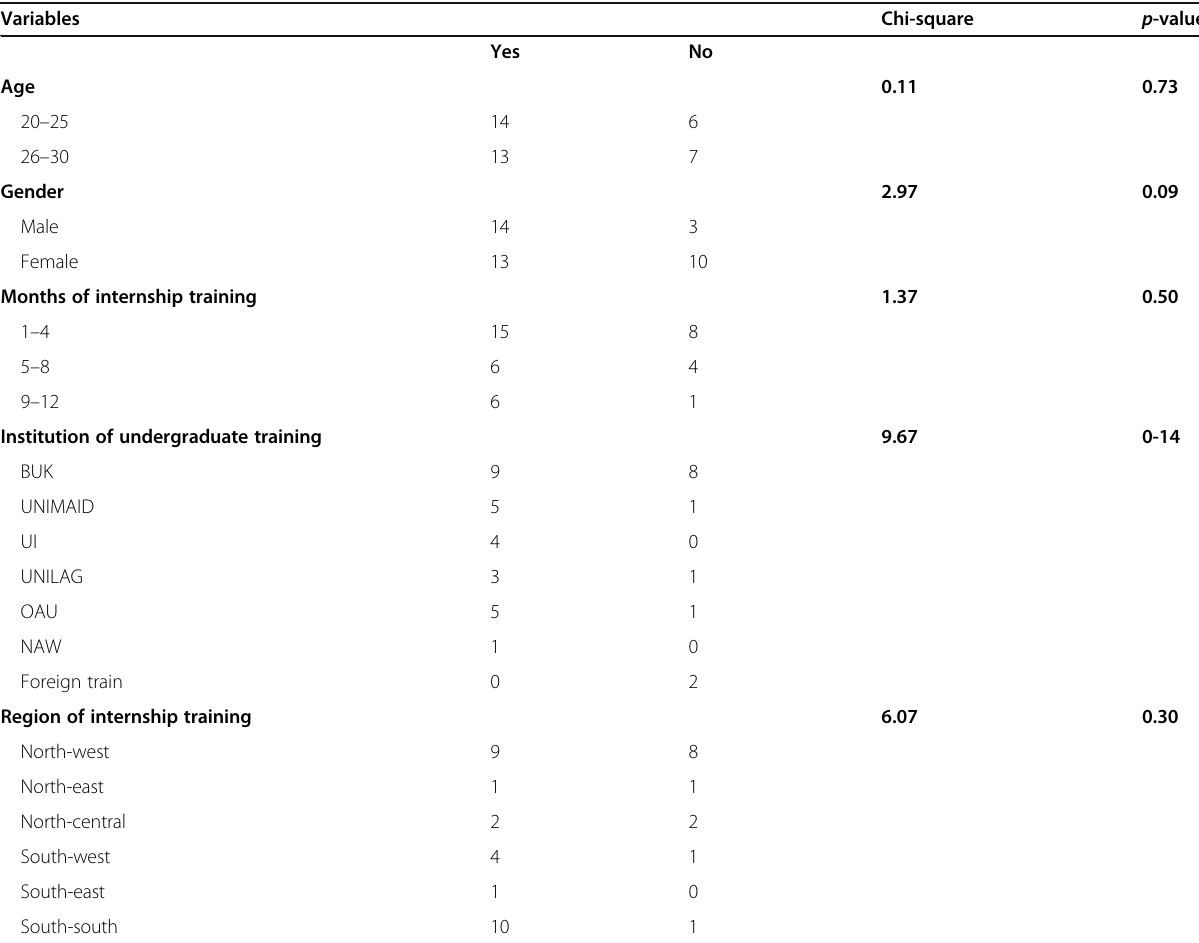
Table 5 Association between socio-demographic variables and the prevalence of mistreatment